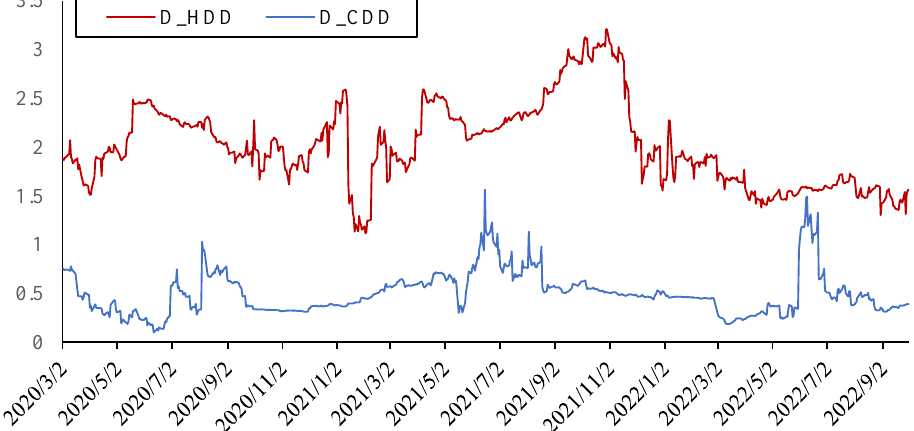
Figure 11. Dynamic spillover effects from HDD and CDD to other indicators.